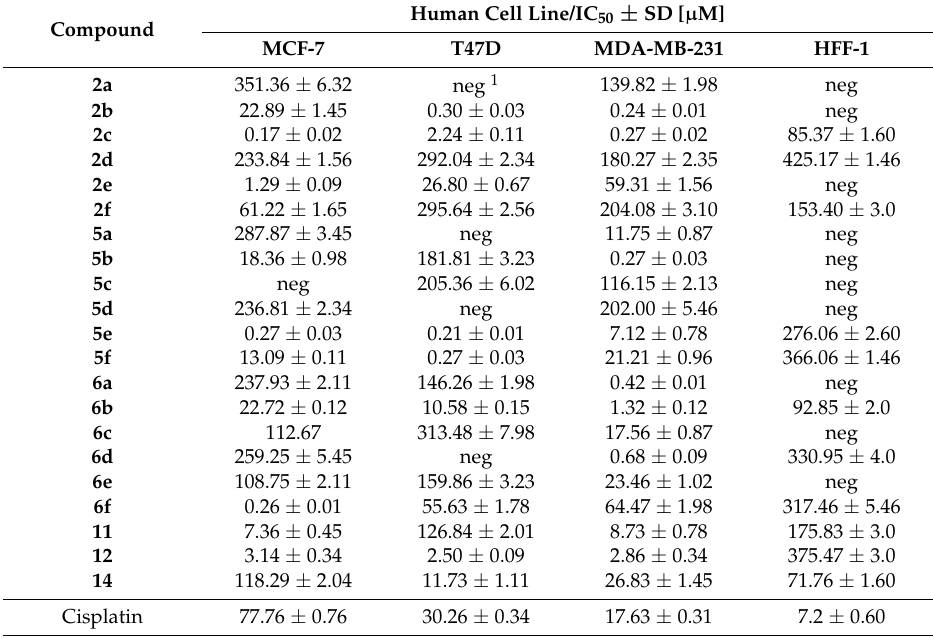
Table 1. Cytotoxic activity of acetylenic quinolines and cisplatin as a reference